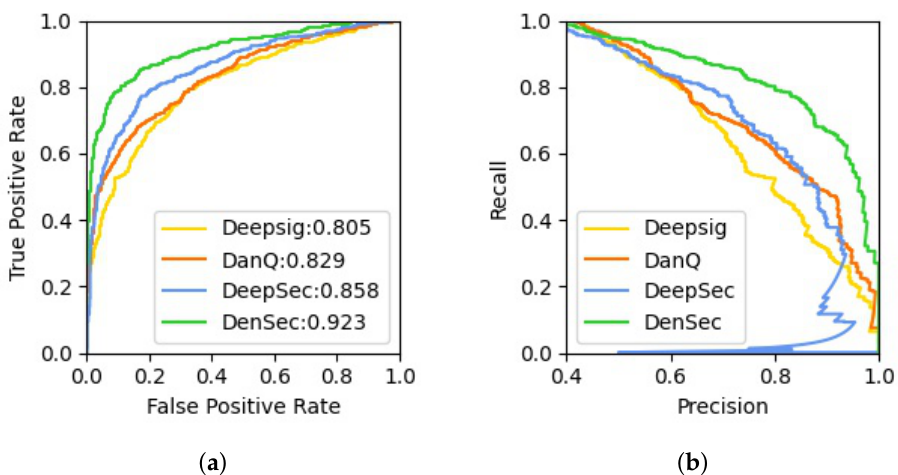
Figure 3. The ROC curves and the Precision-Recall curves for CSF protein prediction differentiation of DenSec versus other deep learning models: ( a ) the ROCs on the testing dataset; ( b ) the Precision- Recall curves on the testing dataset.